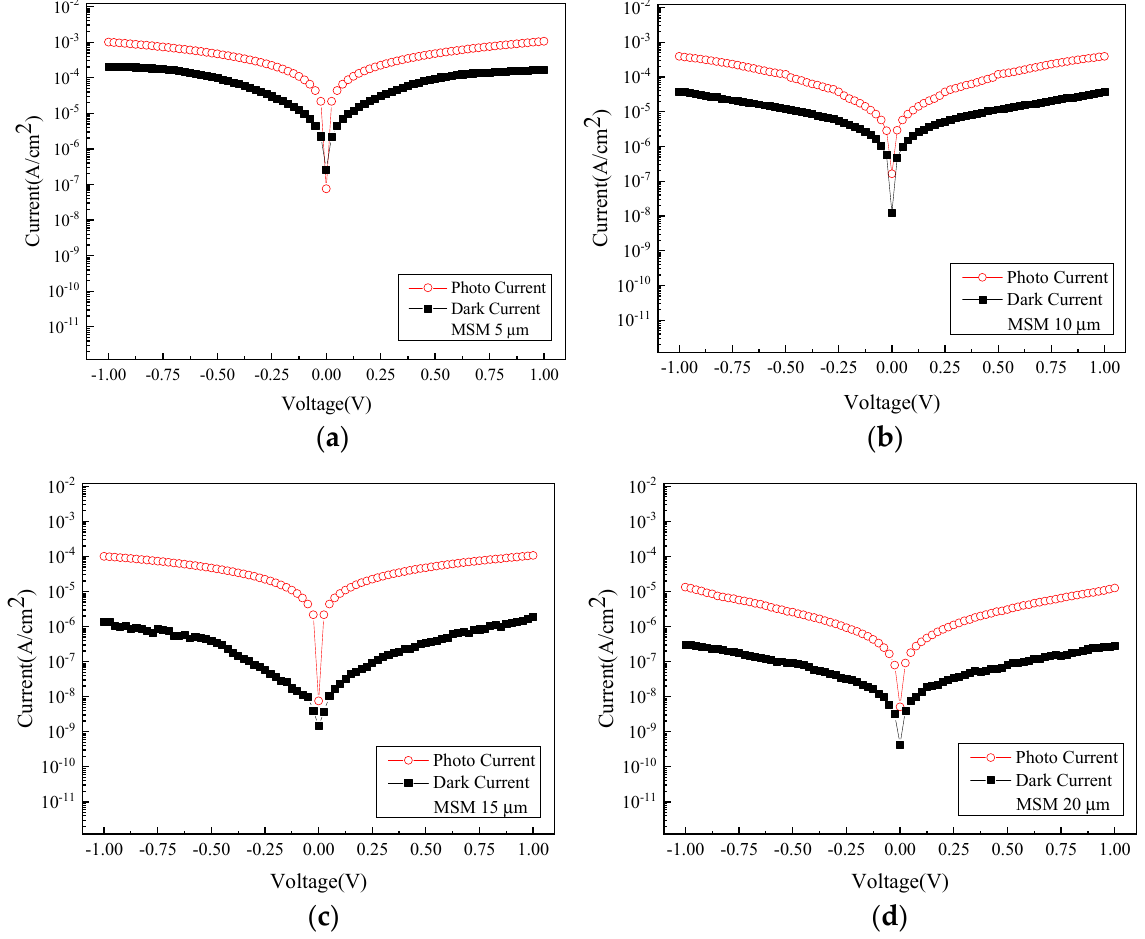
Figure 4. The photocurrent and dark current density between different sizes: ( a ) 5 µm, ( b ) 10 µm, ( c ) 15 µm, and ( d ) 20 µm.